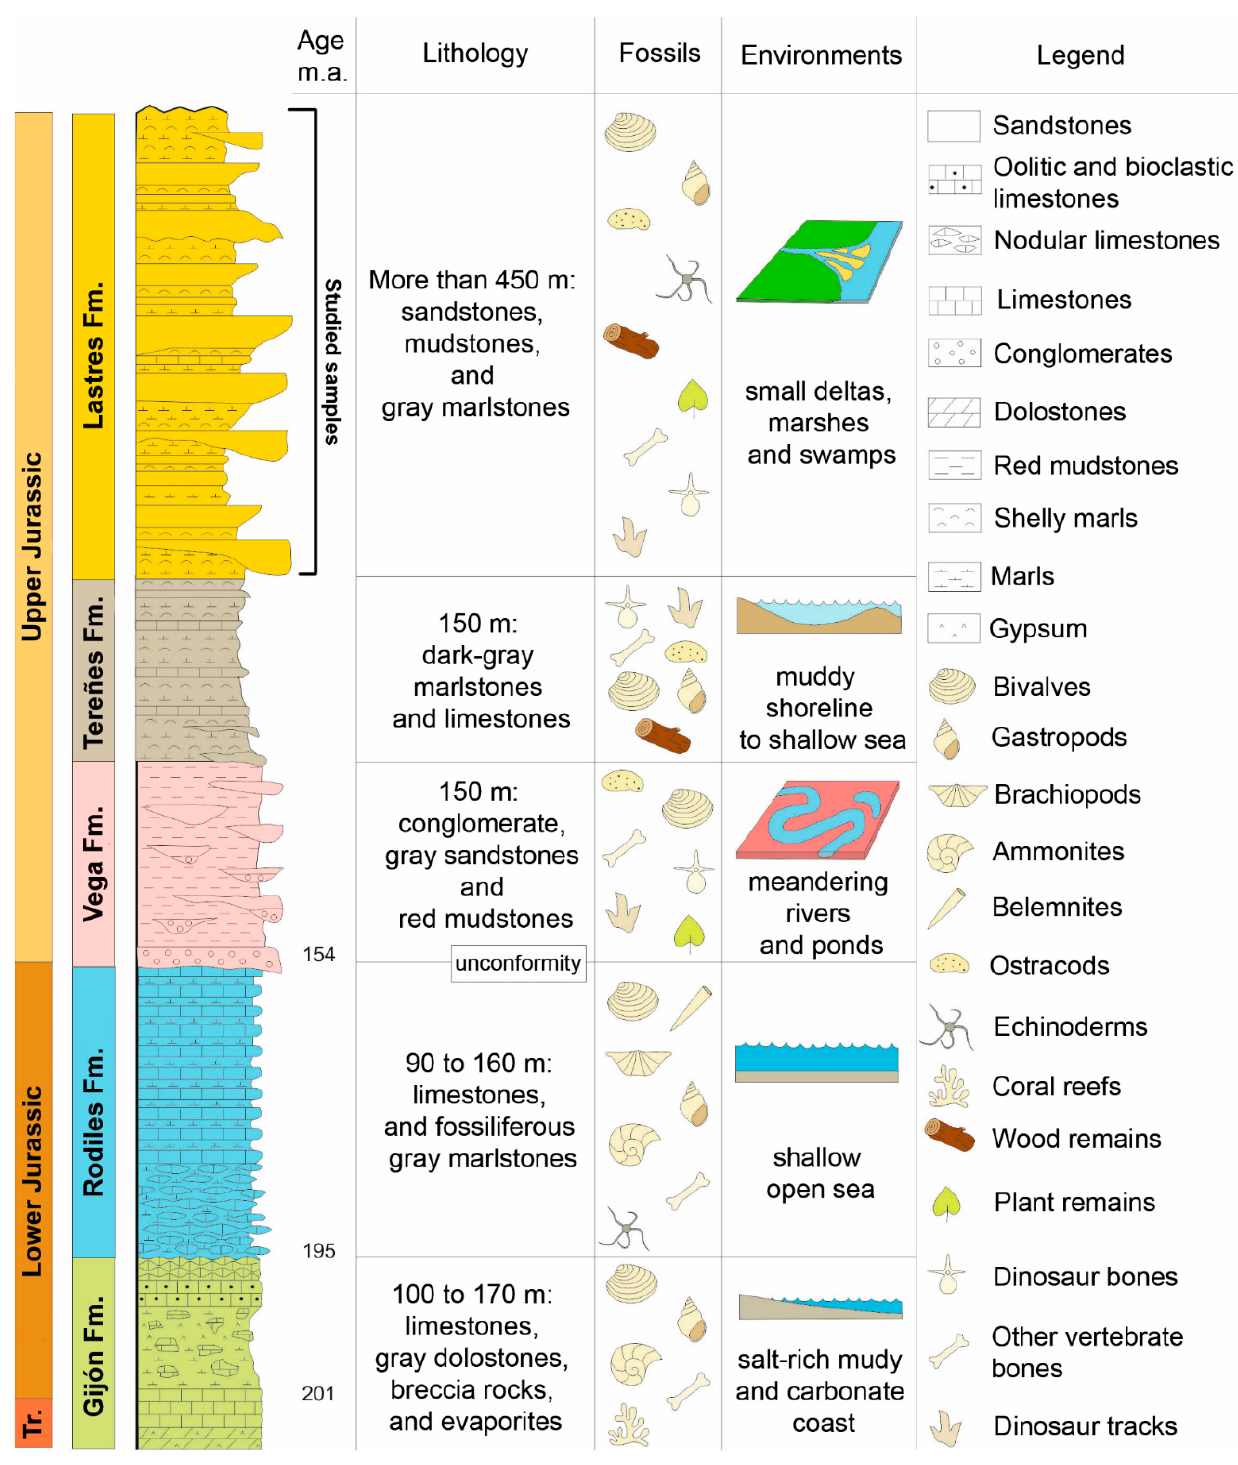
Figure 2. Lithostratigraphical and palaeoenvironmental context of “The Dinosaur Coast” of Asturias.